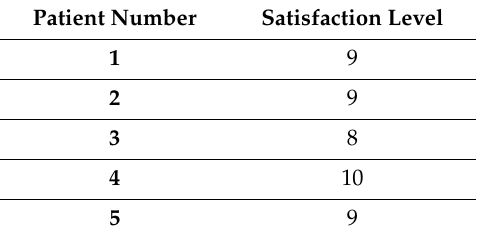
Table 5. Patients’ satisfaction. Results at three months after treatment.